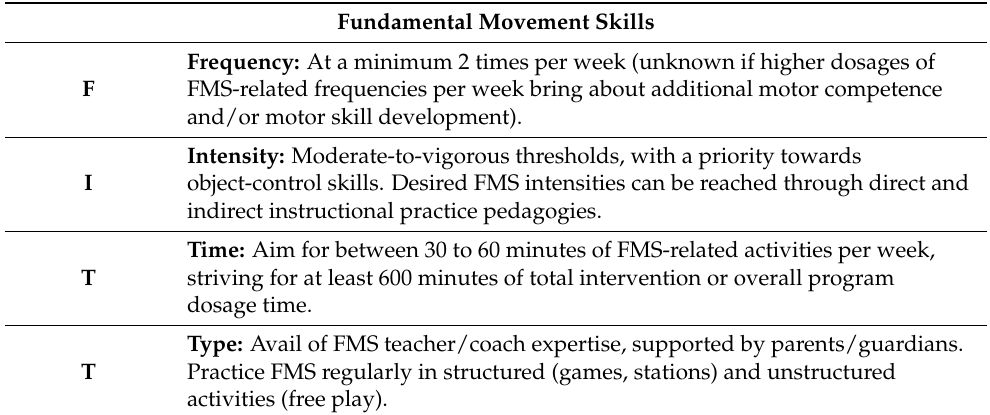
Table 3. The FITT formula: identified guideline ranges for the FMS development of children and